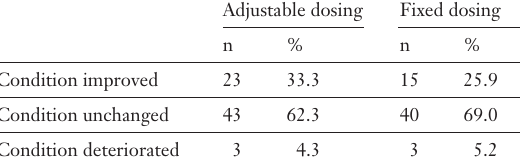
Change of asthma condition (NHLBI severity level [1]) under